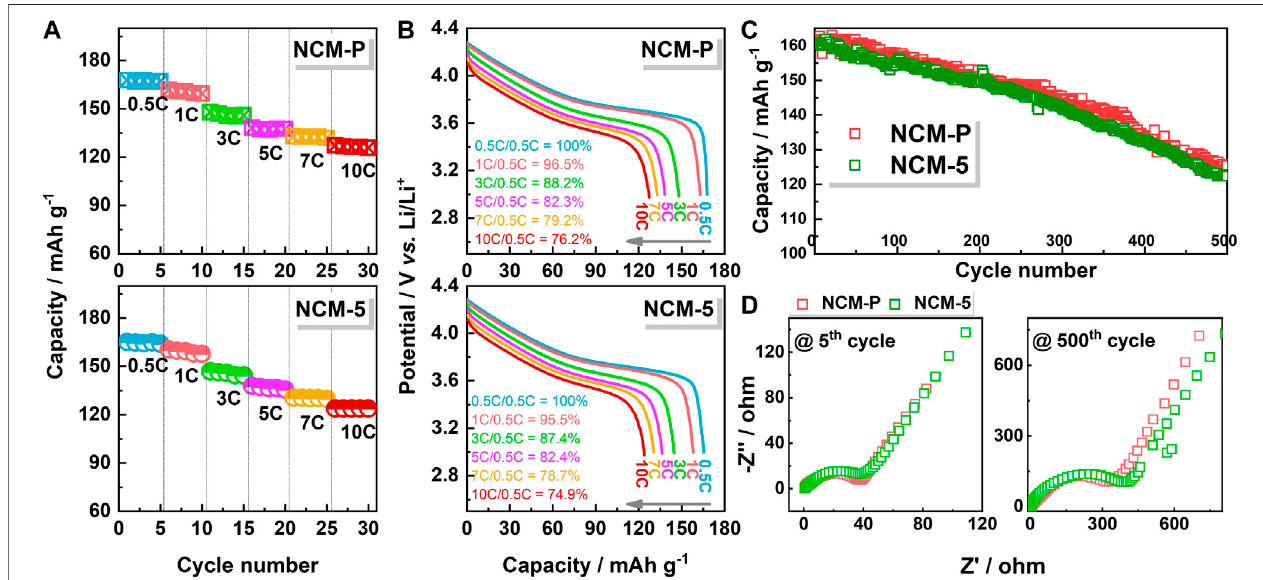
FIGURE 4 | (A) Rate capability, (B) detailed discharge pro fi les, (C) long-term cycling performance and (D) Nyquist plots for NCM-P and NCM-5.